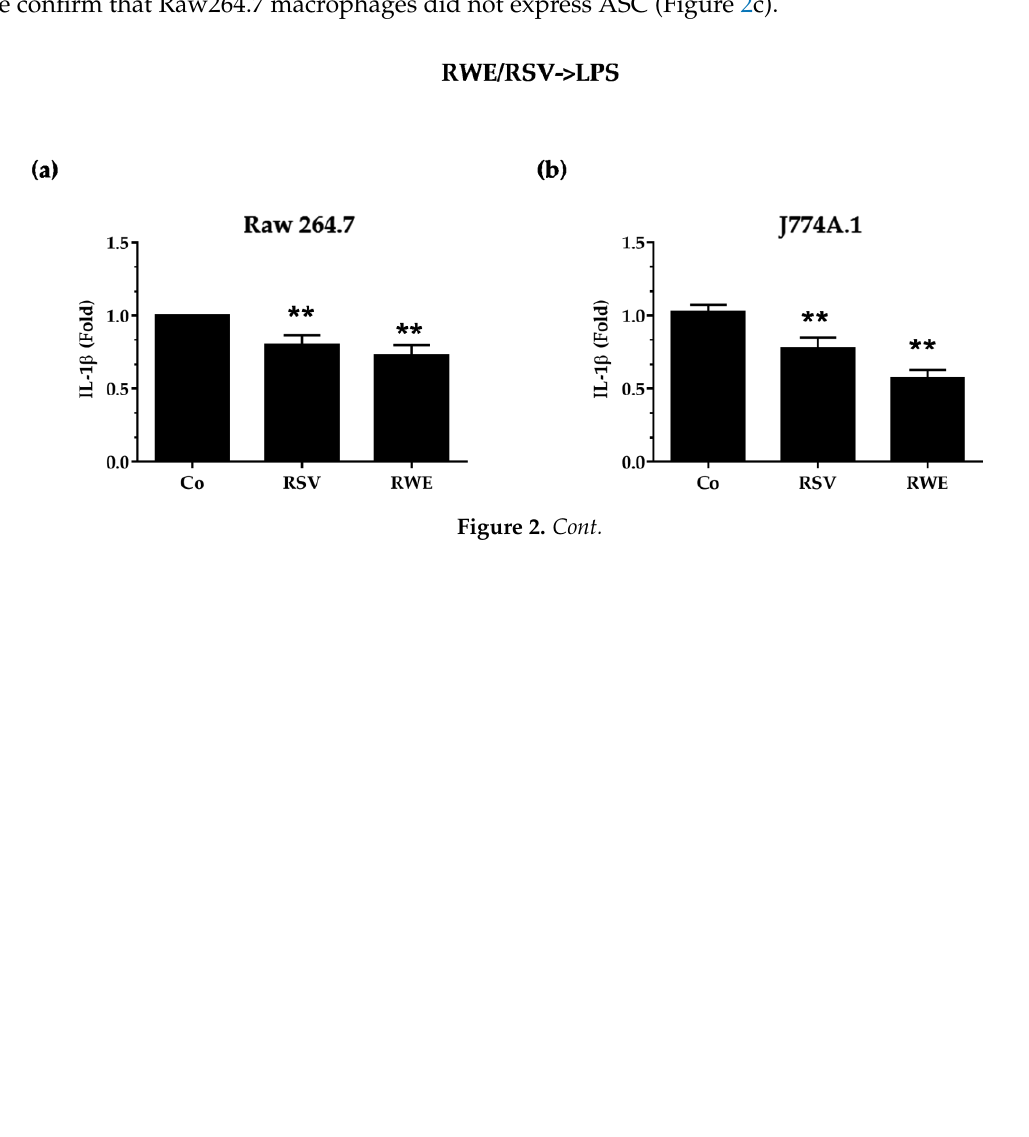
Figure 2. RWE and RSV decrease IL-1  secretion in lipopolysaccharide (LPS)-mediated NLRP3 inflammasome priming conditions. Raw 264.7 ( a ) and J774A.1 ( b ) macrophages were pretreated or